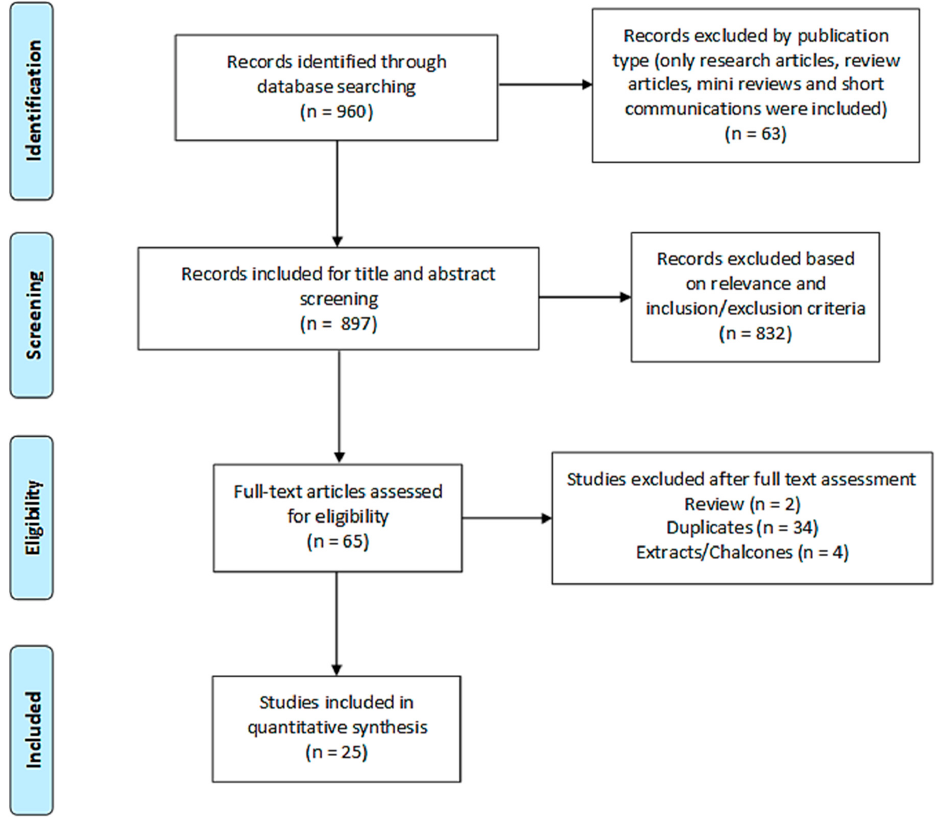
Figure 5. PRISMA flow diagram of study search and selection process of Section 2 .